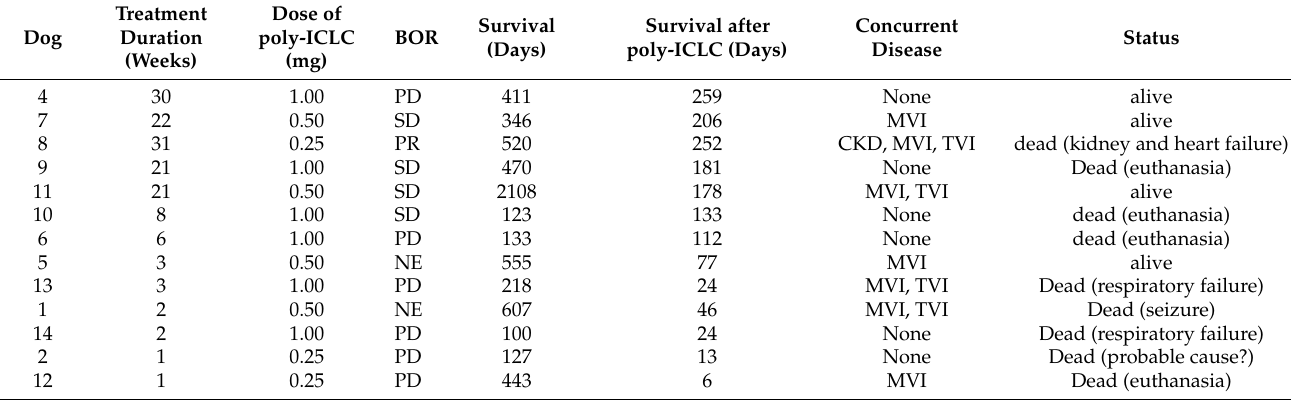
Table 2. Response to treatment of target lesions injected with poly-ICLC. Dogs were separated according to the number of weeks of treatment.